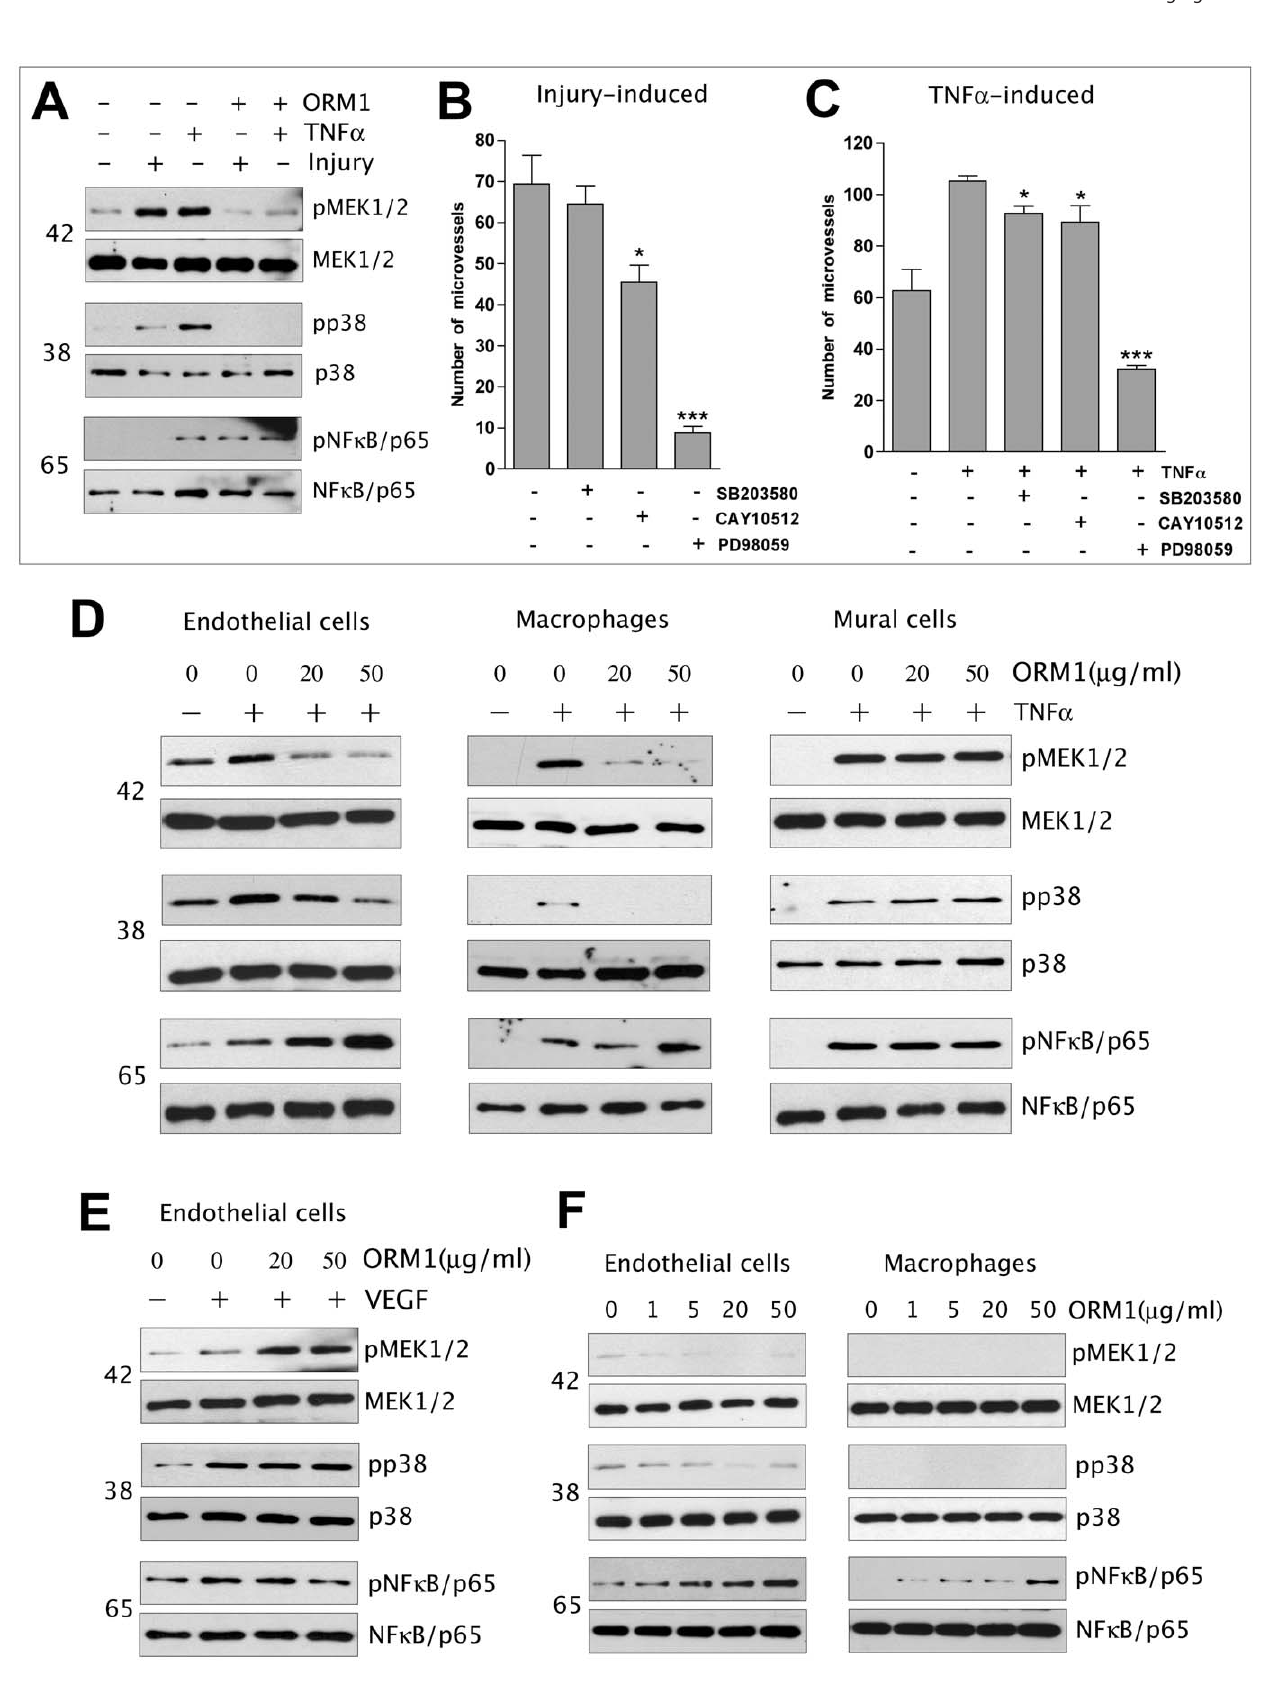
Figure 6. Effect of ORM1 on signal transduction in aortic explants and isolated endothelial cells, macrophages or mural cells. (A). ORM1 inhibits injury- and TNF a (20 ng/ml)-induced phosphorylation of MEK1/2 and p38, but has no effect on TNF a -induced phosphorylation of